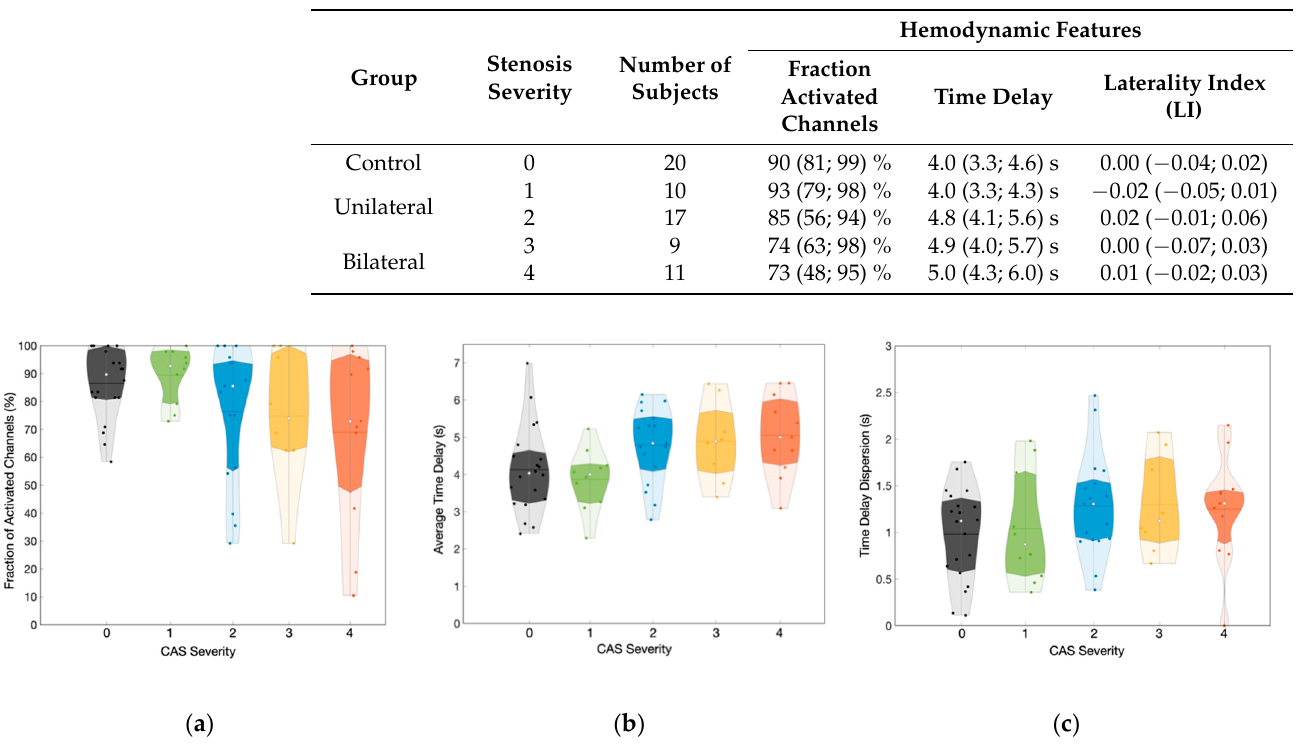
Table 2. Features of the hemodynamic response due to the breath-holding challenge as a function of stenosis severity. In all cases, the hemodynamic parameters calculated from fNIRS are shown as the median (25% percentile; 75% percentile) across all subjects within each group.